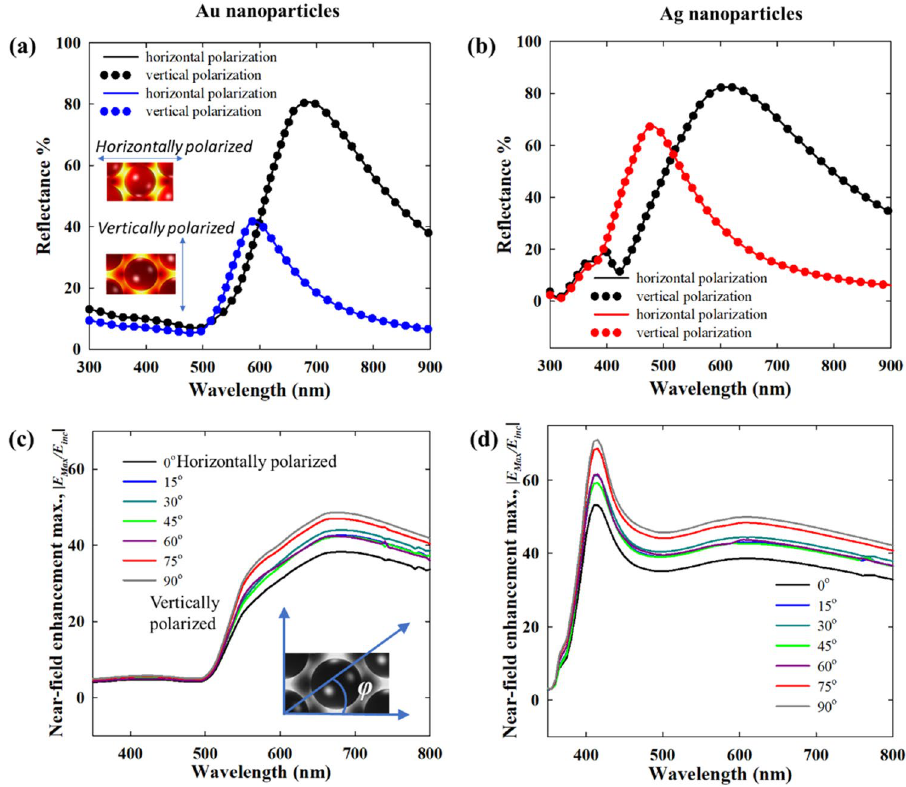
Figure 9. Comparison of reflectance spectra of Au ( a ) and Ag ( b ) nanoparticle assemblies under normal illumination with 1 nm and 4 nm interparticle gaps at two perpendicular polarizations. The maximum near- field enhancement spectra of Au ( c ) and Ag ( d ) nanoparticle assemblies (shown only for an interparticle gap of 1 nm) at different polarization angles denoted by φ . Horizontal polarization, φ = 0° and vertical polarization, φ = 90° are defined w.r.t to the plane of the screen. The incident wave is normal to the plane of the nanoparticle film in all cases. (embedding medium, n =